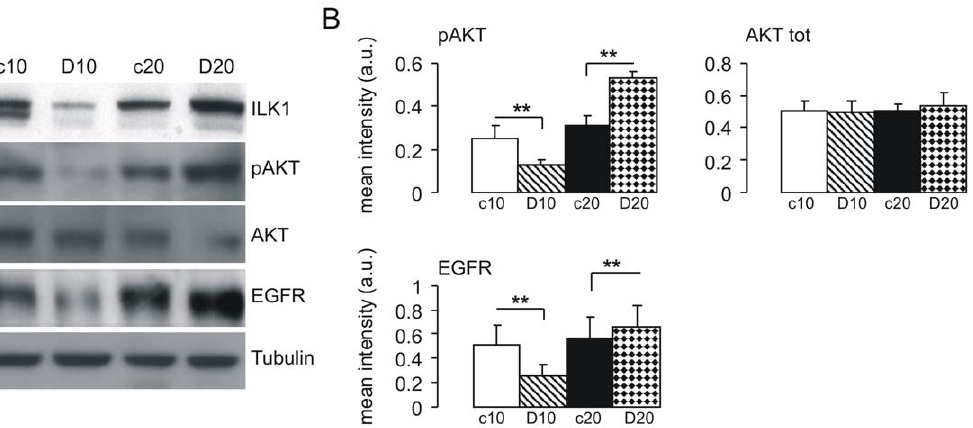
Figure 3. Immunoblotting analysis of ILK1, pAKT and EGFR in PF4-DLR treated glioblastomas. Tissue lysates of the treated (D10 and D20) and untreated (c10 and c20) tumors were prepared as described in Materials and Methods, and the proteins were resolved on 10–12% PAGE gels. A) The proteins were blotted onto a nitrocellulose membrane and detected with antibodies raised against the individual proteins indicated on the right side of each panel. B) Histograms of the mean band intensity ( 6 SEM) of each protein. *p , 0.05, t test.